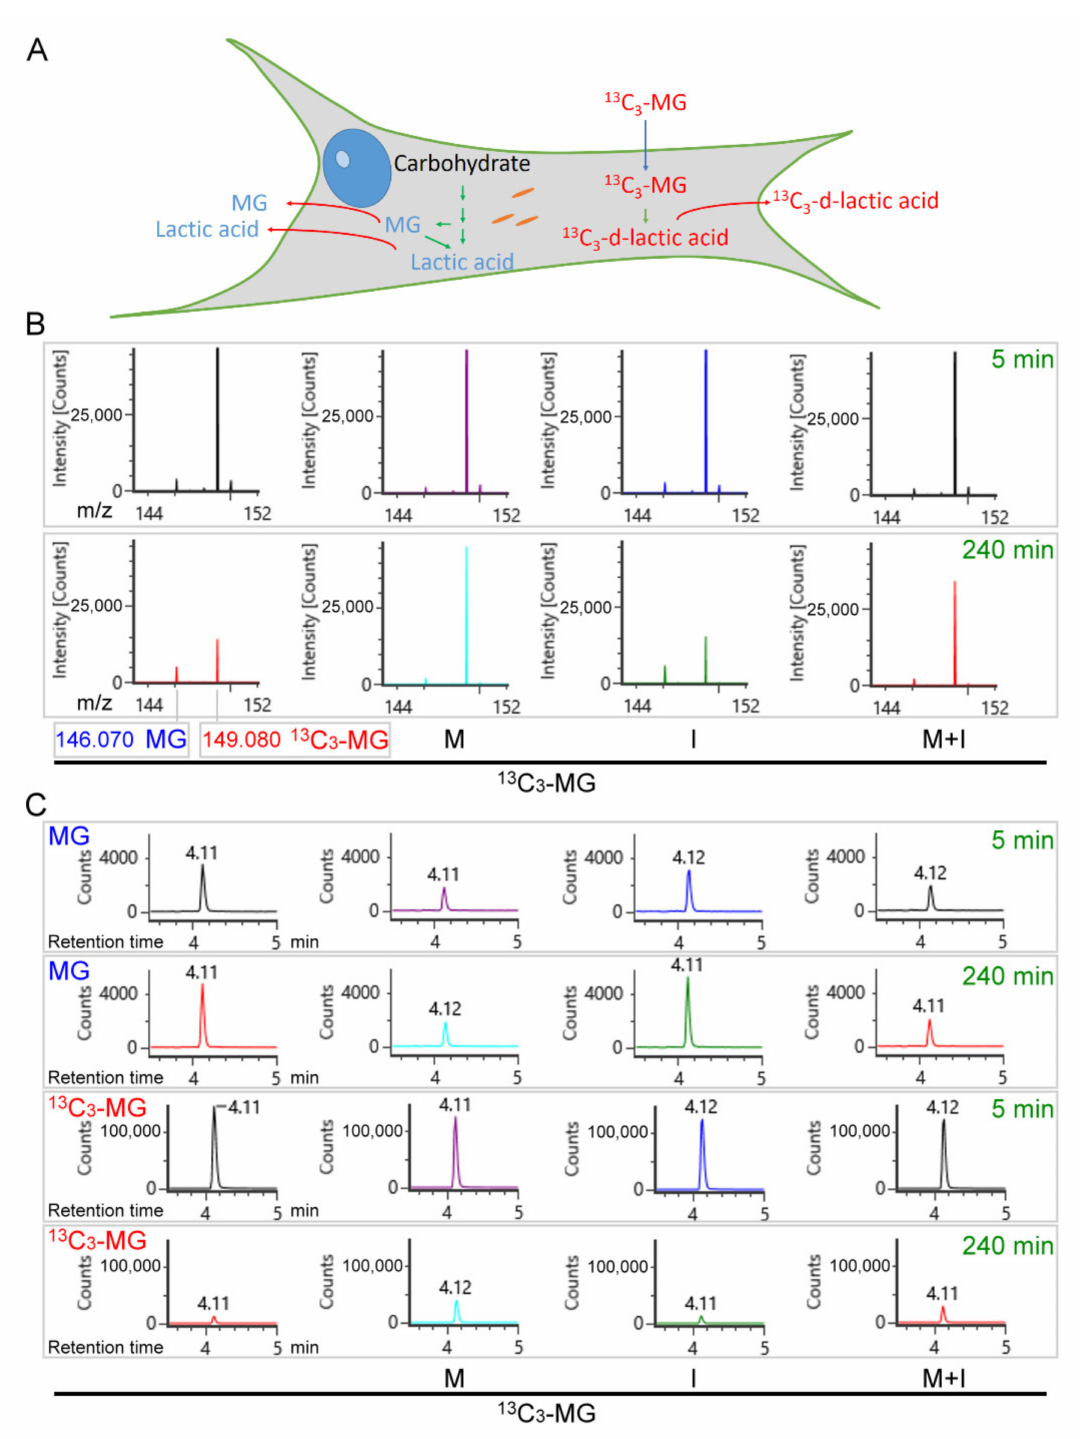
Figure 4. Using isotopic 13 C 3 -MG to track the metabolism of extracellular MG. ( A ) The related intermediates from MG or carbohydrate are derived from either intracellular or extracellular origin. ( B ) Mass spectrum and ( C ) chromatogram of methylglyoxal (MG) and 13 C 3 -MG were acquired by LC-ESI-MS analysis of the medium collected from HEK293T cell culture with the indicated conditions. M: 10 mM metformin; I: 10 ng/mL insulin; M + I: 10 mM metformin + 10 ng/mL insulin; 13 C 3 -MG: 80 µ M 13 C 3